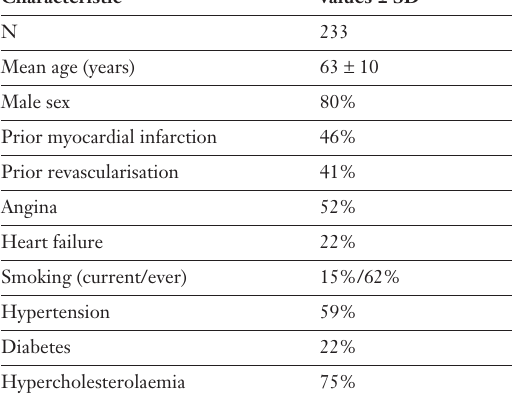
Baseline characteris- tics of the study population.